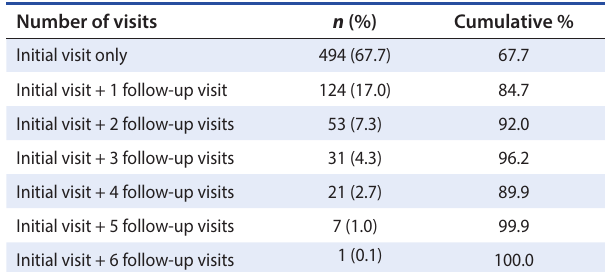
Table 2: Number of clinic visits ( n = 730)